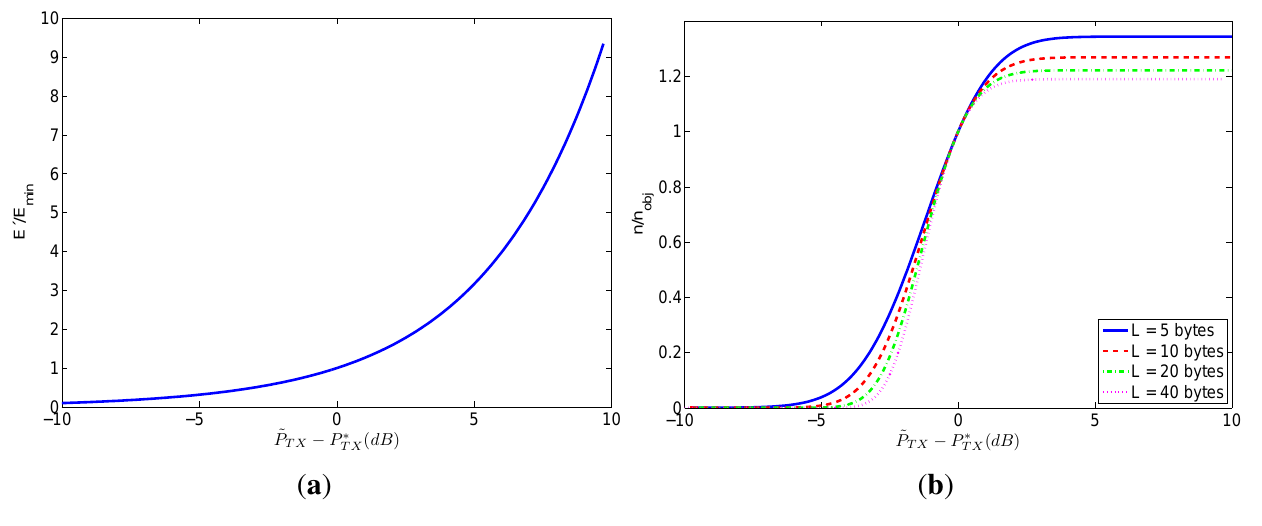
Figure 4. Effect of the error in the transmission power on the energy consumption and on the number of received